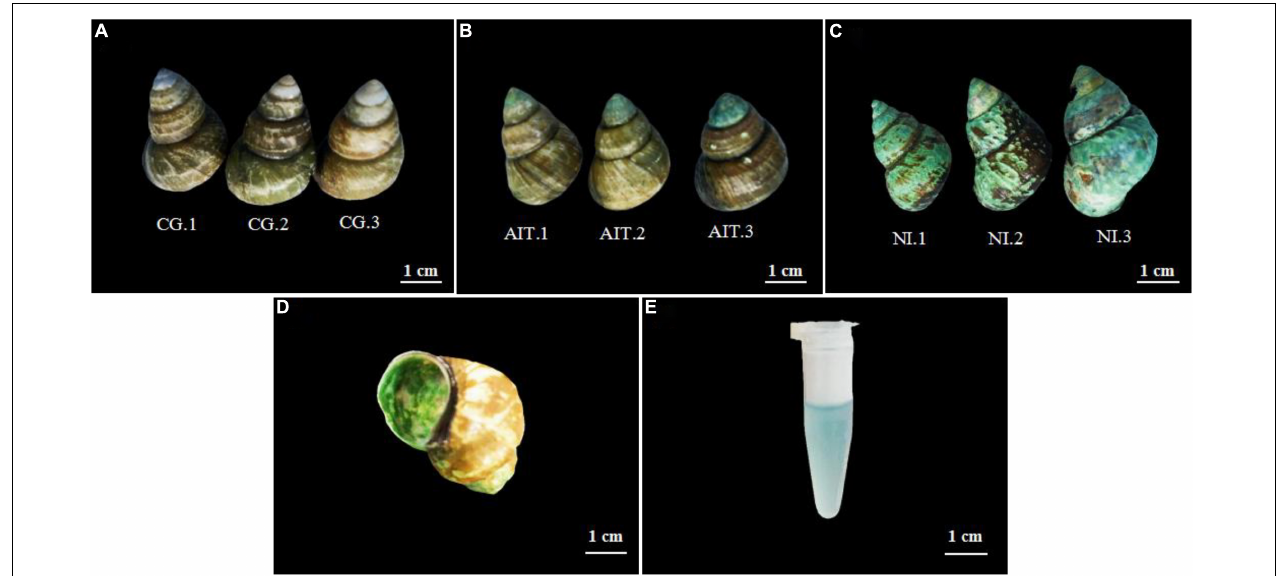
FIGURE 6 | Morphological changes of the snail shell after infection and bioerosion at the laboratory level. (A) Healthy snail shell, control group (CG); (B) artificial infection group (AIT); (C) natural infection bio-eroded experimental group (NI); (D) internal morphology of bio-eroded shell; (E) phycocyanin infiltrated from the shell.